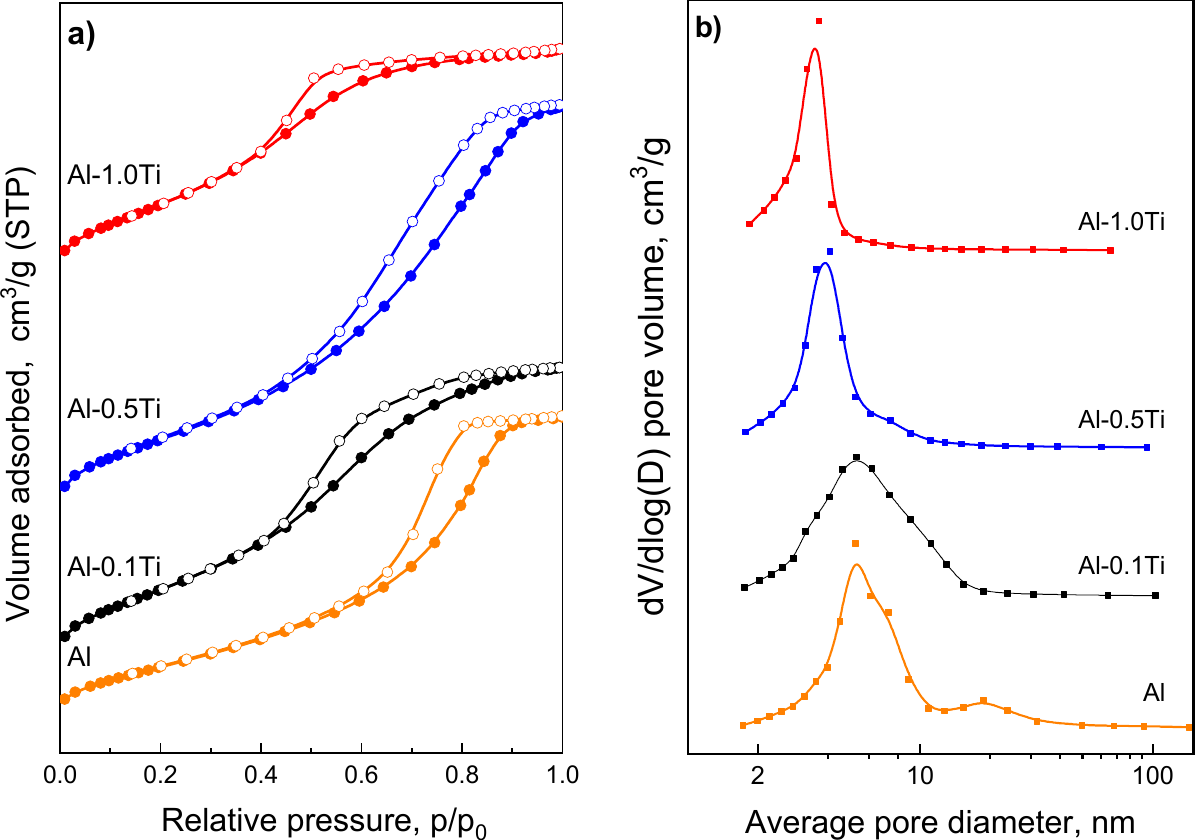
Figure 4. Low-temperature nitrogen adsorption–desorption isotherms ( a ) and pore volume distribution ( b ) of the Al 2 O 3 and binary Al-Ti oxide supports calcinated at 500 °C. Table 2. BET surface area, pore volume and average pore diameter of oxide supports and platinum catalysts.